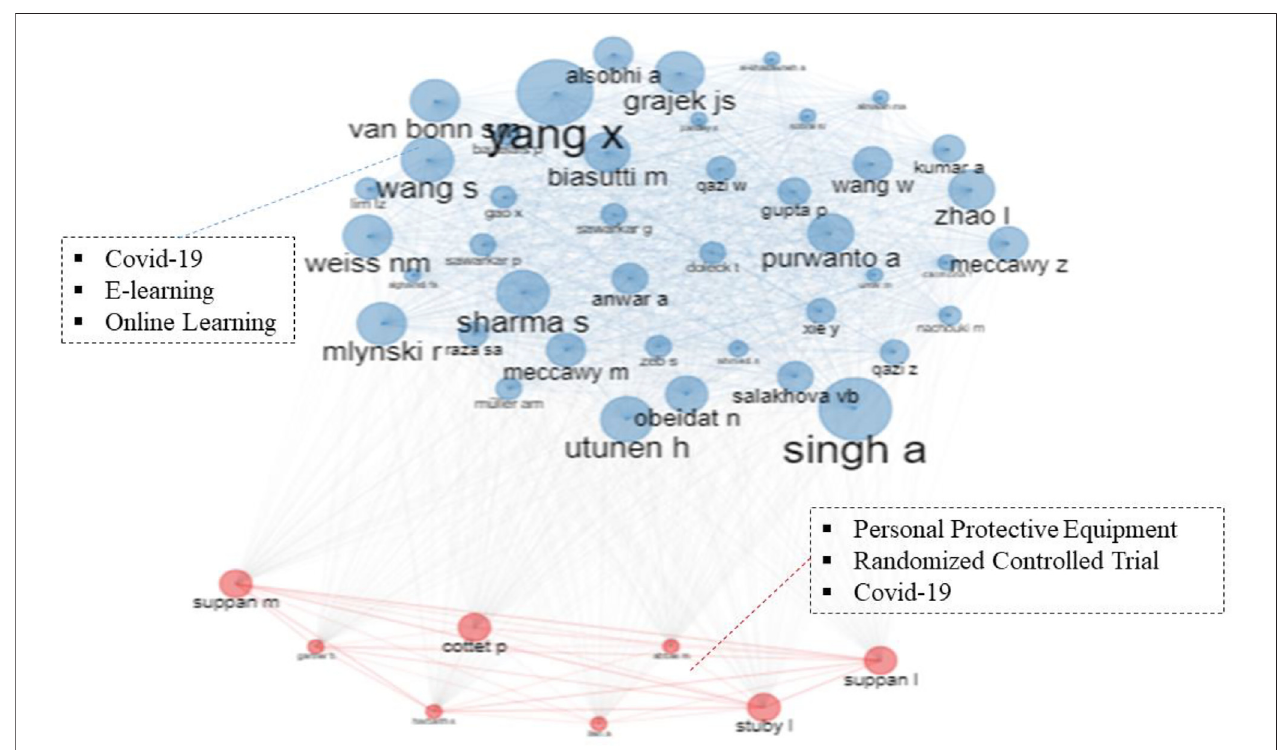
FIGURE 9 | Coupling map.